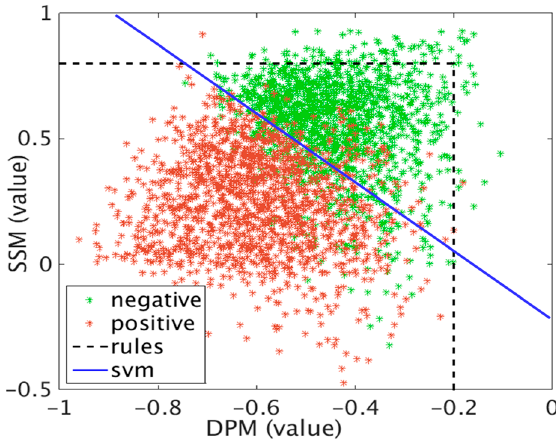
Figure 8. Positive (red asterisks) and negative (green asterisks) classification of SVM classifier. DPM and SSM represent the value of DPM (Difference Probability Mean) and SSM (SSIM Mean) mentioned in Section 3.3. The prior rules are indicated by dotted black lines. The blue line represents the boundary between positive and negative NCBAs by SVM classifier.